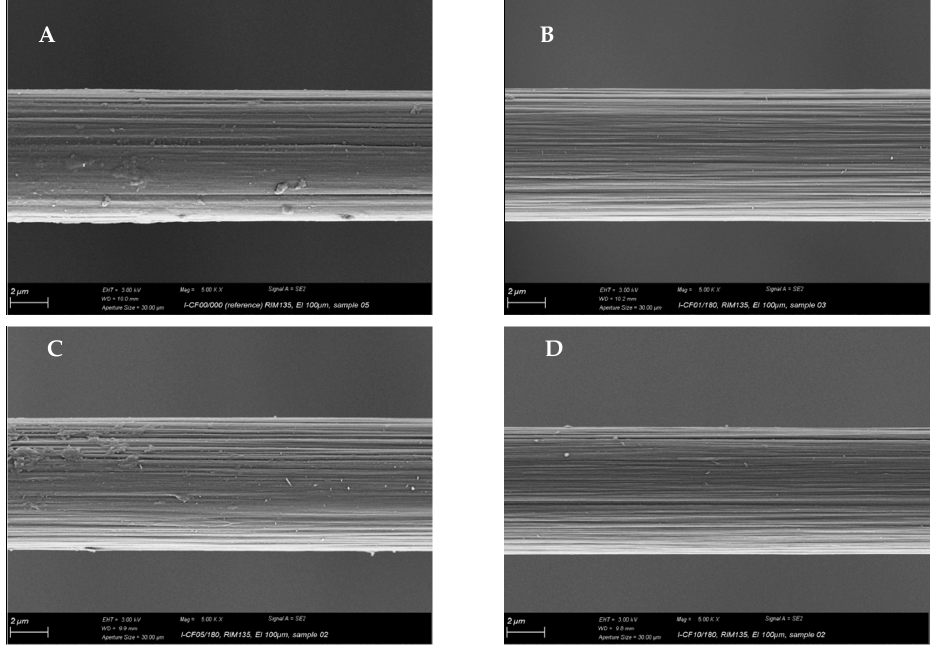
Figure 11. SEM of pulled-out single fibers of I-CF00/000 (reference) ( A ), oxy-fluorinated samples with 1 vol% F 2 (I-CF01/180) ( B ), and 5 vol% F 2 (I-CF05/180) ( C ) as well as a fluorinated CF (I-CF10/180) ( D